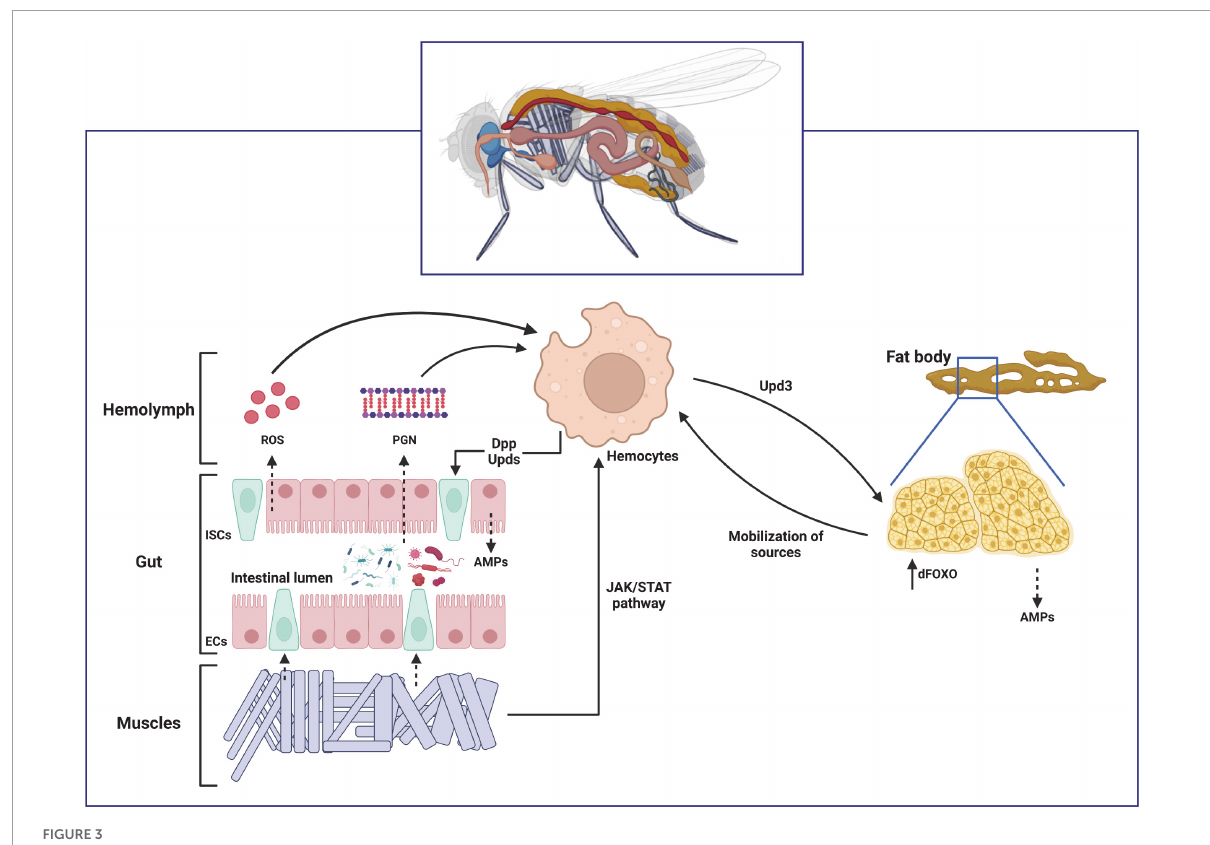
FIGURE3 Schematic representation of the interorgan communication during infection in Drosophila melanogaster . In response to ingested pathogens, these microorganisms might either break the gut epithelium themselves or release peptidoglycan (PGN) from their cell walls into the hemolymph. The enterocytes (ECs) are also able to release reactive oxygen species (ROS) in response to tissue damage. These circulating signals are sensed by the hemocytes located close to the gut epithelium. Hemocyte-expressed Decapentaplegic (Dpp) and Unpaireds (Upds) during early stages of the infection activate the intestinal stem cells (ISCs) proliferation to cope with tissue damage. Hemocytes-derived Upds also induce accumulation of the transcription factor dFOXO in the fat body via JAK/STAT pathway. Activation of dFOXO induces expression of AMPs and a systemic metabolic dysregulation that mobilizes energy resourced toward phagocytic cells. Finally, infection-induced Upd3 in enterocytes activate the JAK/STAT signaling pathway in visceral muscles (VM), which in turns promote ISCs proliferation, as well as activation of the close-located